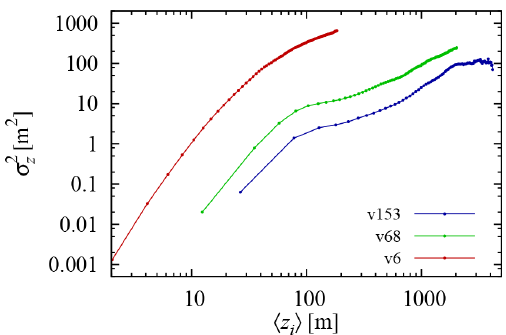
Figure 9. Variance of depth reached by the particles as a function of their mean